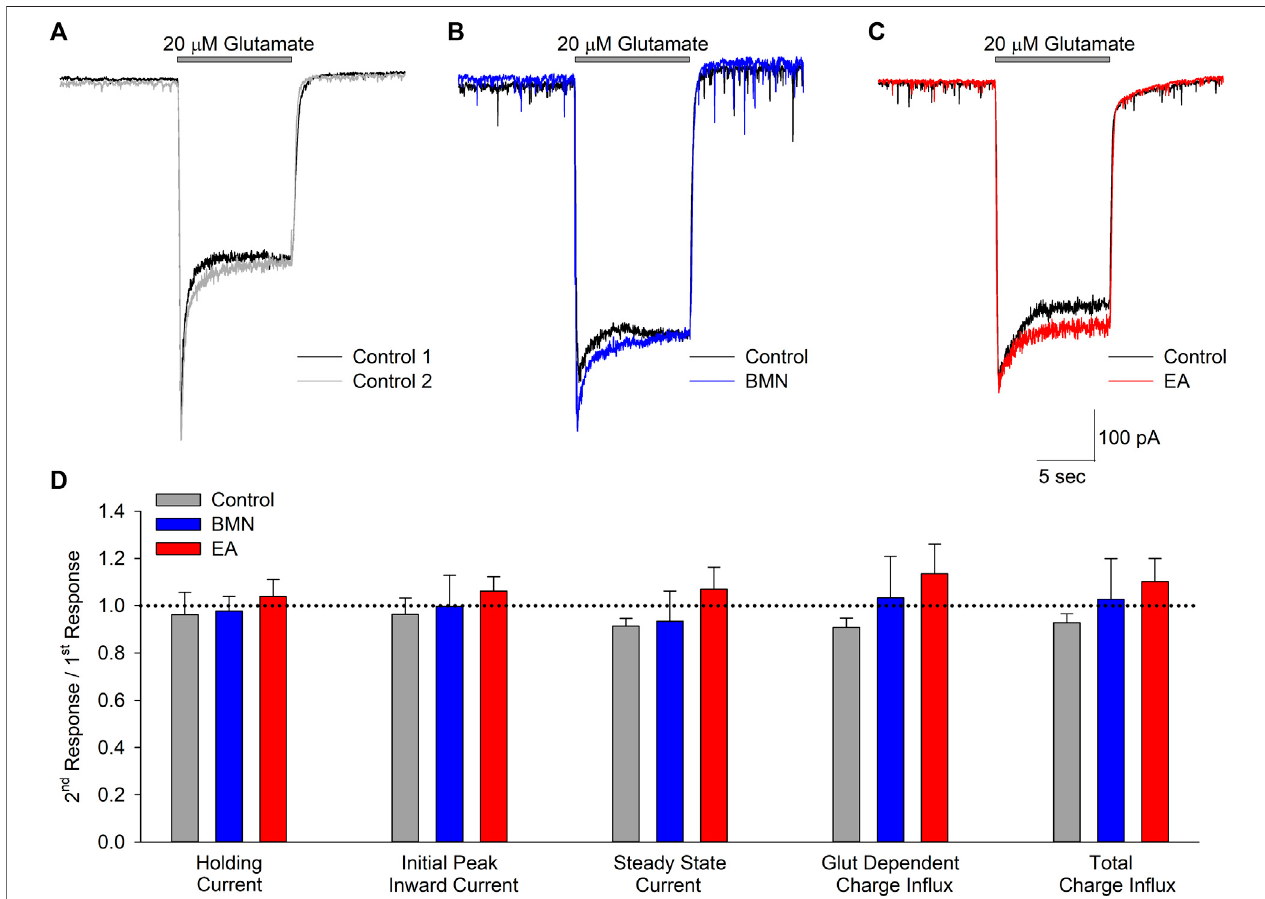
FIGURE 4 | Glutamate activated inward currents are not inhibited by bumetanide or ethacrynic acid. (A) , Representative traces of whole-cell currents recorded from a single neuron voltage clamped at − 70 mV in response to two 10 s applications of 20 μ M glutamate. (B) , Representative traces of whole-cell currents recorded from a single neuron voltage clamped at − 70 mV in response to a 10 s application of 20 μ M glutamate in the absence (Control, black trace) and presence of 100 μ M bumetanide(100 μ MBMN,bluetrace). (C) ,Representativetracesofwholecellcurrentsrecordedfromasingleneuronvoltageclampedat − 70 mVinresponsetoa 10 s application of 20 μ M glutamate in the absence (Control, black trace) and presence of 100 μ M ethacrynic acid (100 μ M EA, red trace). (D) , Bar graph of compiled data from experiments identical to those in A ( n (cid:1) 5), B ( n (cid:1) 4) and C ( n (cid:1) 4). Data are shown as the ratio of second responses to fi rst responses in the absence (Control) and presence of drug (BMN or EA). Data shown are mean response ratios ( ± SEM) of holding current, initial peak and steady state (measured at the end of the 10 s application)inwardcurrents,andchargein fl uxduringglutamateapplication (GlutDependent)andthroughouttherecording(Total).Nosigni fi cantdifferenceswerenoted for any of the parameters measured ( p > 0.12 for all). Bars above traces in A-C denote times of glutamate